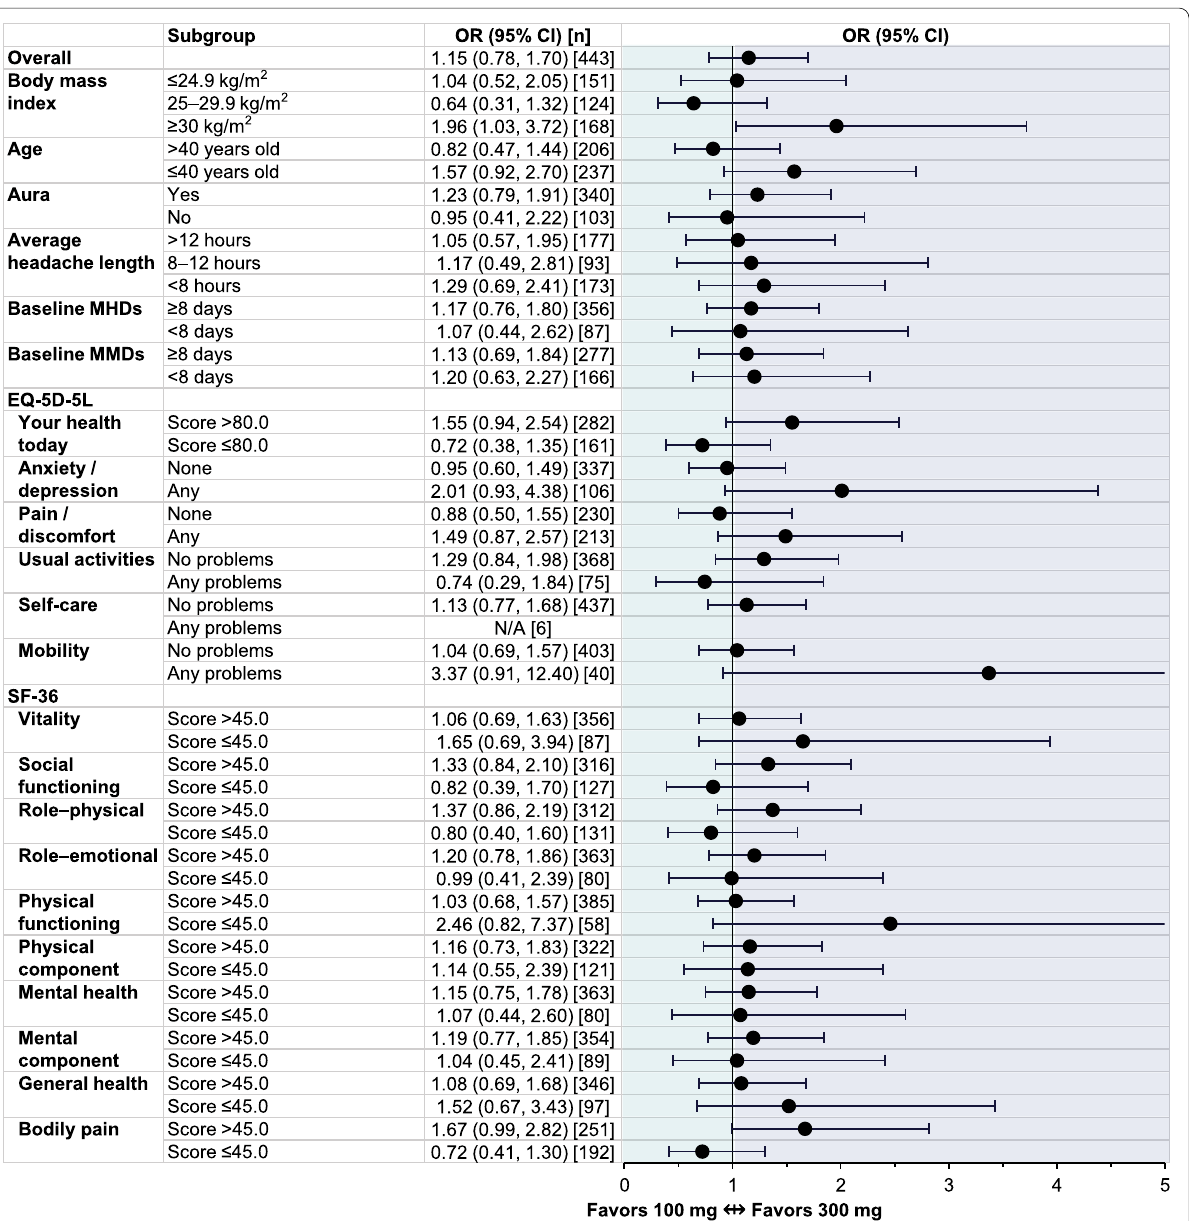
Fig. 3 Odds ratio of 50% MRR over Weeks 13 ‒ 24 in PROMISE-1 subgroups defined by baseline demographics and patient-reported outcome ≥ measures. CI, confidence interval; EQ-5D-5L, EuroQol 5-dimension, 5-level scale; MHDs, monthly headache days; MMDs, monthly migraine days; MRR, migraine responder rate; N/A, not applicable (sample size too small); OR, odds ratio; SF-36, 36-item Short-Form Health